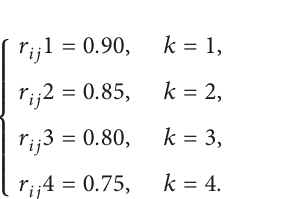
Table 4: The specific needs of the